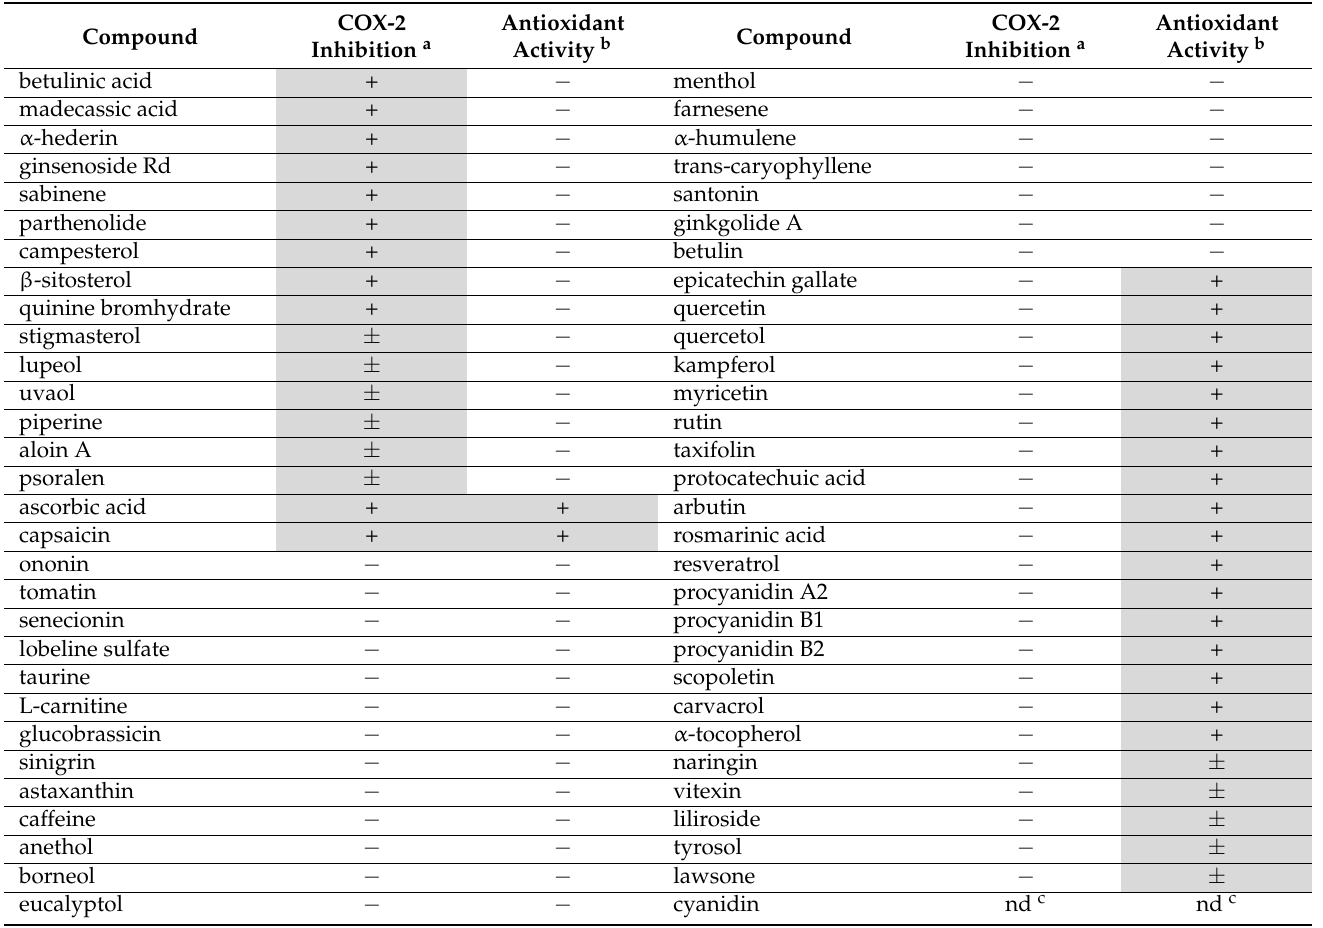
Table 2. COX-2 inhibition and antioxidant activity for some standard natural products (tested